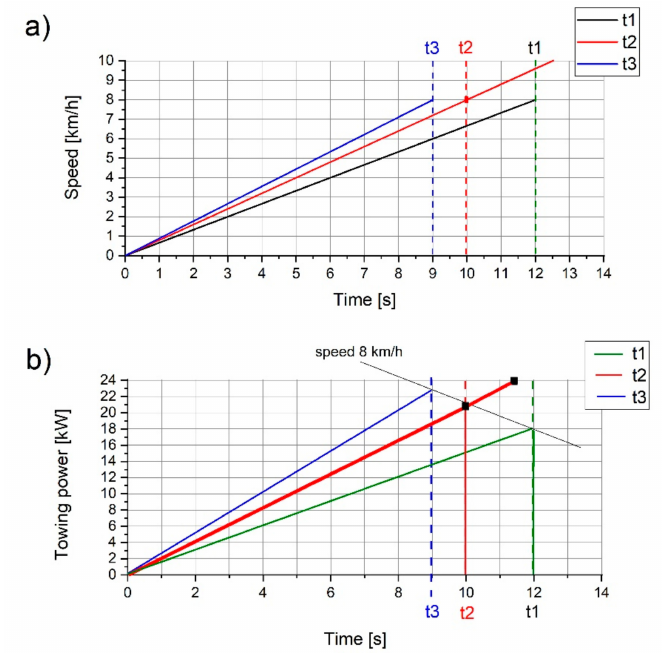
Figure 5. Measurement results in the model test laboratory during the acceleration of the model, showing acceleration variants from t1 to t3: ( a ) The speed distribution of the ship and ( b ) the towing power of the